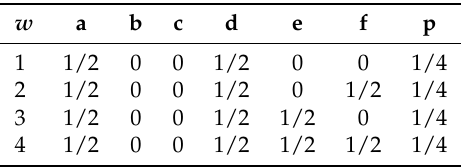
Table 1. The coefficients a i ,b i ,c i ,d i ,e i ,f i of the affine transforms w n (first column) in Equation (4), and the probabilities p i (last column) associated with each affine